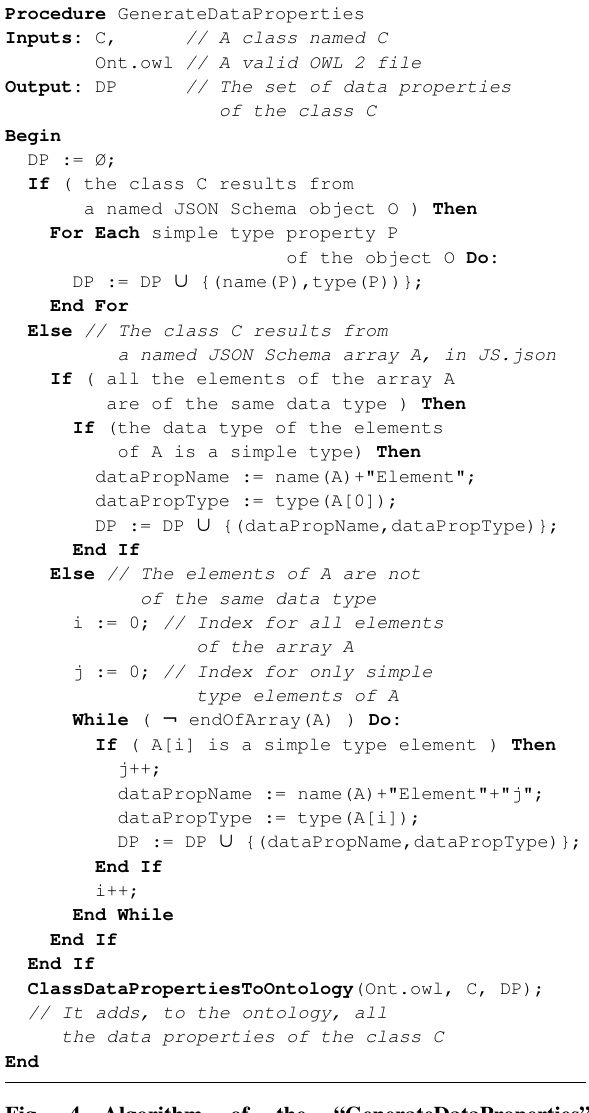
Fig. 4 Algorithm of the “GenerateDataProperties”